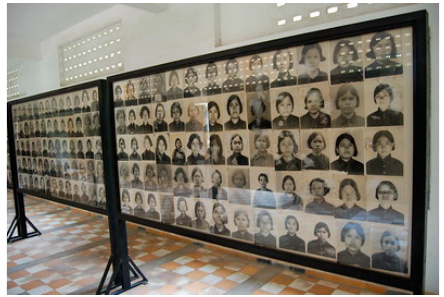
Figure 3. Female victims of the Khmer Rouge, Security Prison 21 (S-21), Tuol Sleng Genocide Mu- seum, Phnom Penh, Cambodia. resource from: https://search.creativecommons.org/pho- tos/607ce54b-74dd-4e44-b310-ce2a80e437f1 (accessed on 25 March